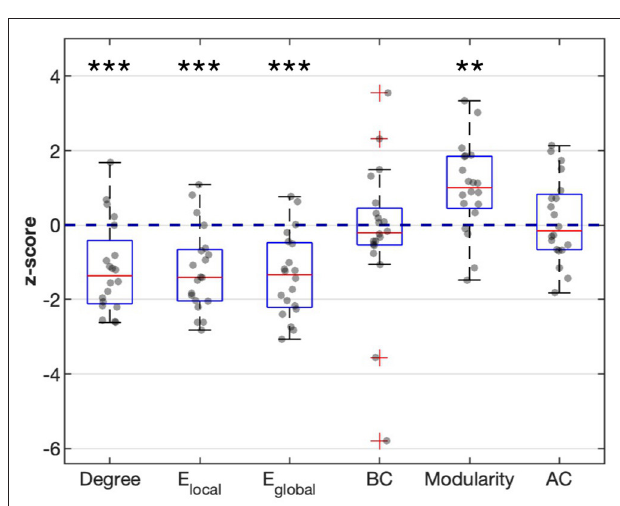
FIGURE 3 | Z-scores of degree, local efficiency E local , global efficiency E global , betweenness centrality (BC), modularity, and assortativity coefficient (AC) in the contralateral hemispheres of the patients relative to the respective hemispheres of the healthy controls (connectivity sparsity = 40%). The z-scores of degree, E local , and E nodal were significantly lower than zero, while the z -score of modularity was significantly higher than zero. Asterisks indicate statistical significance determined by one-sample t -test (** P < 0.005, *** P < 0.001; false discovery rate